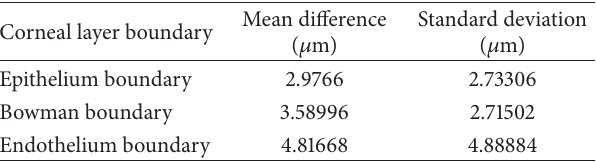
Table 7: The position differences between the two expert manual graders.